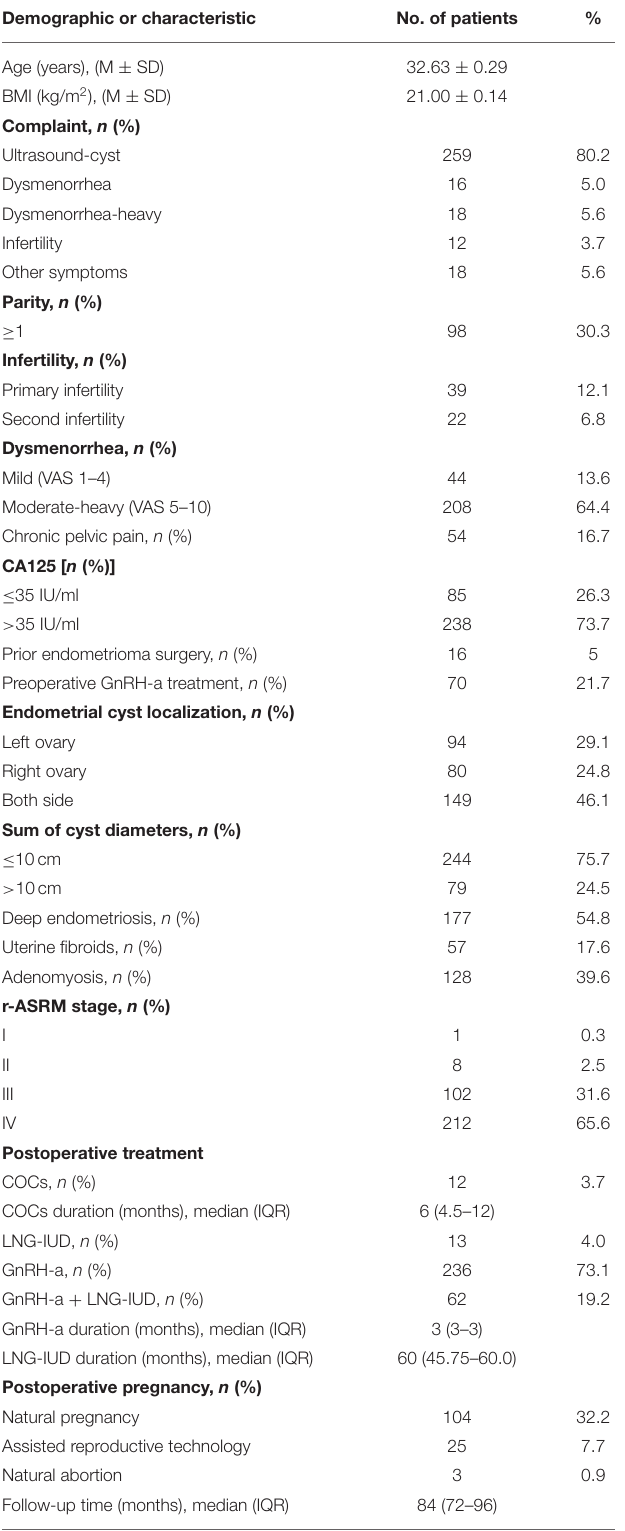
Prognostic Nomogram for Whole Recurrence The prognostic nomogram consisted of all the factors of the multivariate Cox regression model in the derivation cohort.